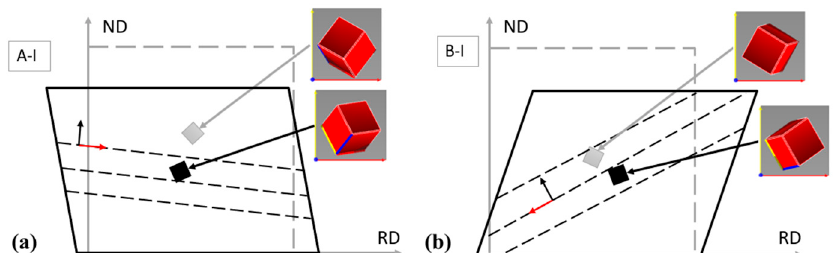
Figure 11. ( a ) and ( b ) is the schematic for samples A-I and B-I before and after deformation. The grey dashed line represents the undeformed geometry, and the deformed geometry is sketched in black. The grey square represents the crystal lattice in the undeformed matrix, and the corresponding deformed shape is shown as a black square. The activated slip system, assuming aligned with the most apparent set of DBs in deformed microstructure, comprises the slip direction (red arrow) and the slip plane (black arrow).